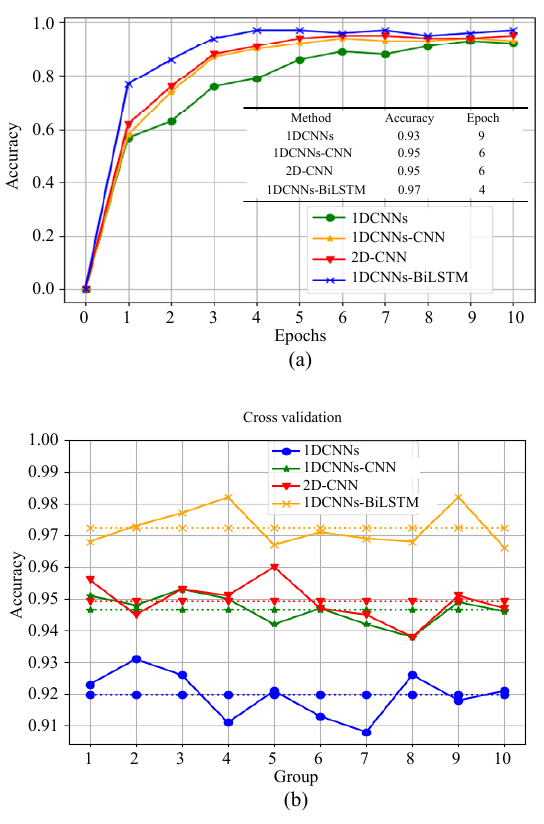
Fig. 38 Convergence processes of 1DCNNs, 1DCNNs-CNN, 2D-CNN, and